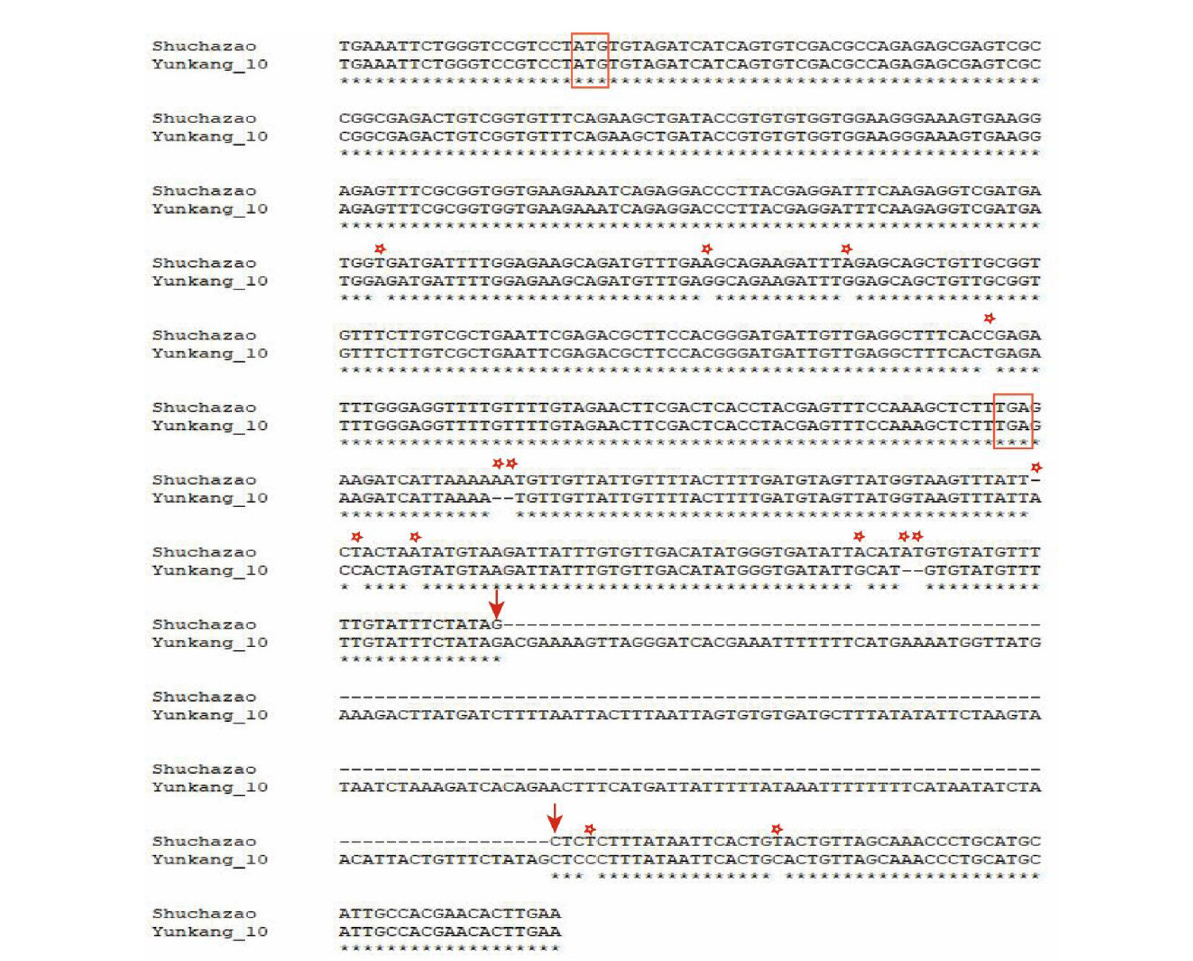
FIGURE9 Visualize SV mutation sites by double sequence alignment. The red box represents the start codon and stop codon. Arrows indicate where SV variation begins and ends. The asterisk represents SNP and small Indel mutations.